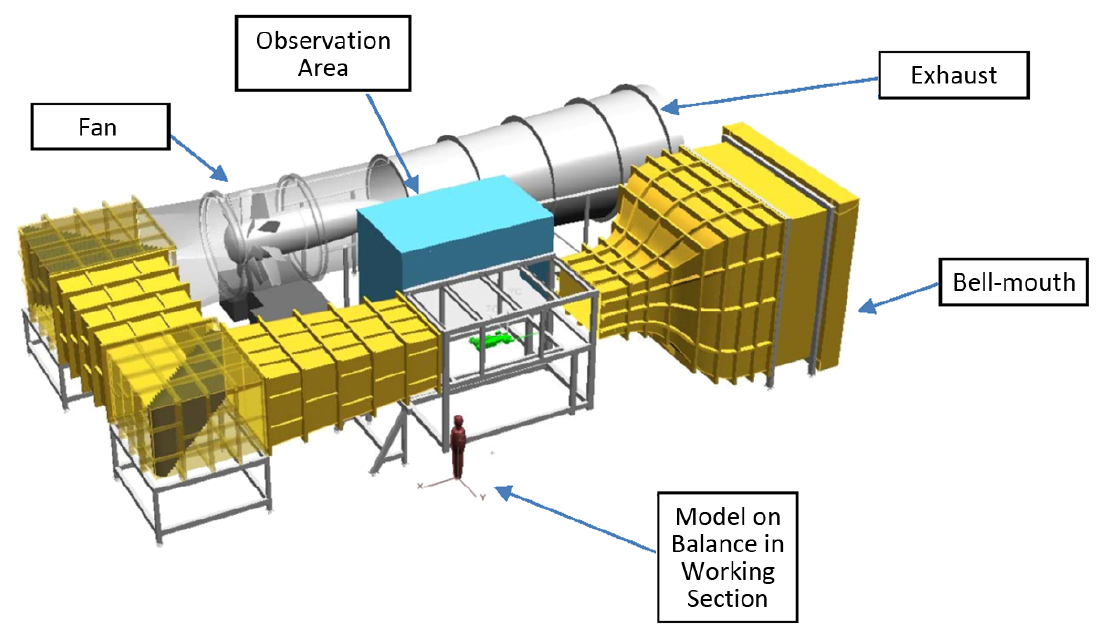
Figure 2. Loughborough university aeronautical and automotive engineering wind tunnel